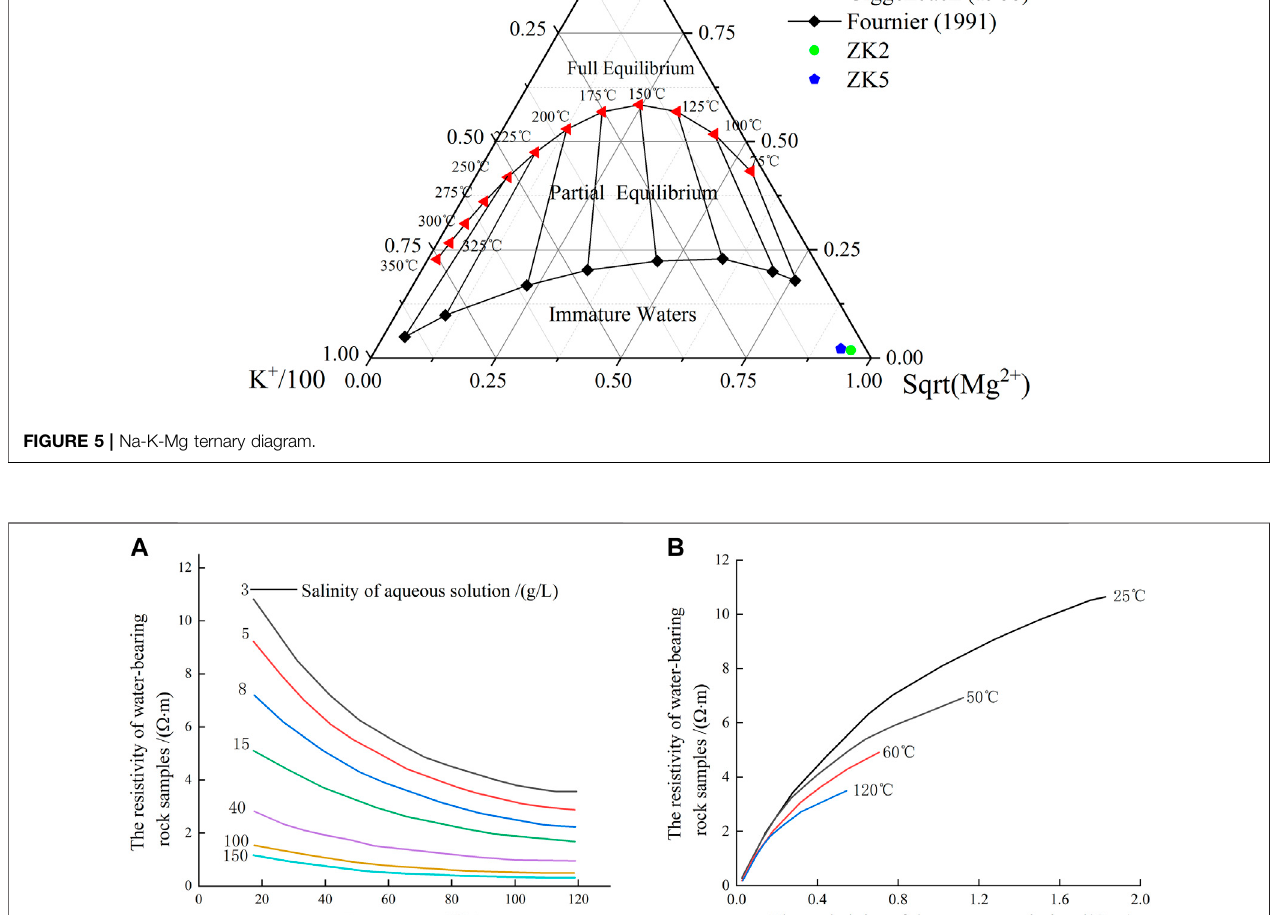
Frontiers in Earth Science |